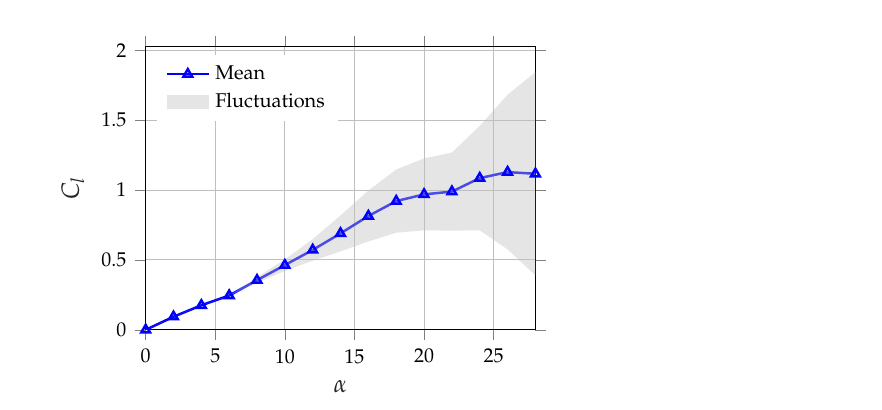
Figure 1. Plot of C l v/s α for Re = 1000. Gray shaded region denotes the amplitude of fluctuations in C l .